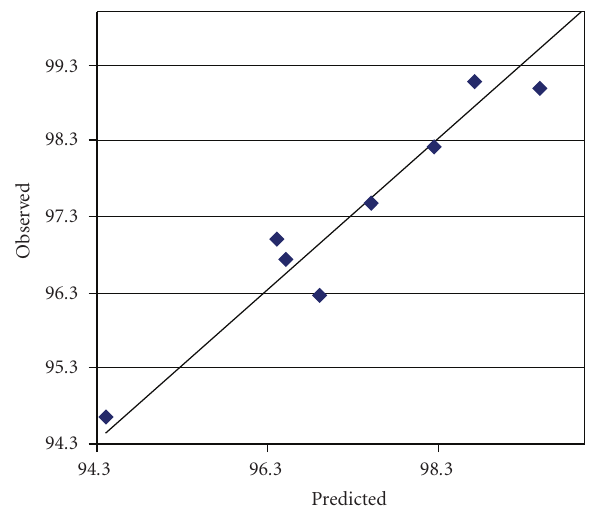
Figure 4: Experimental versus predicted